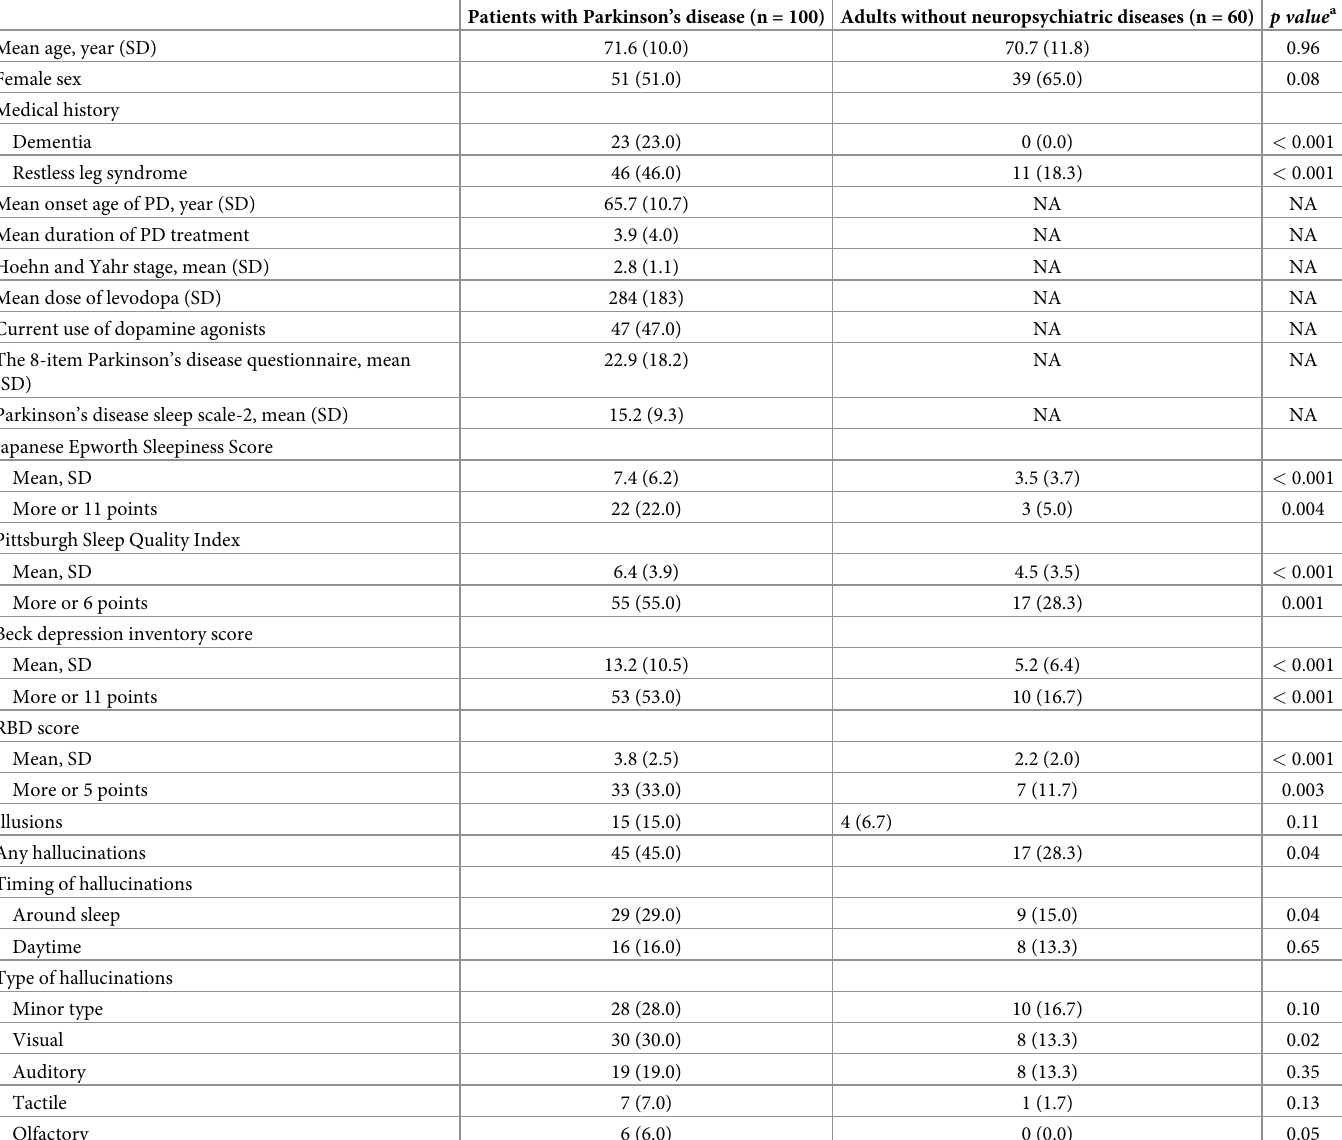
Table 1. Characteristics of patients with Parkinson’s disease and adult